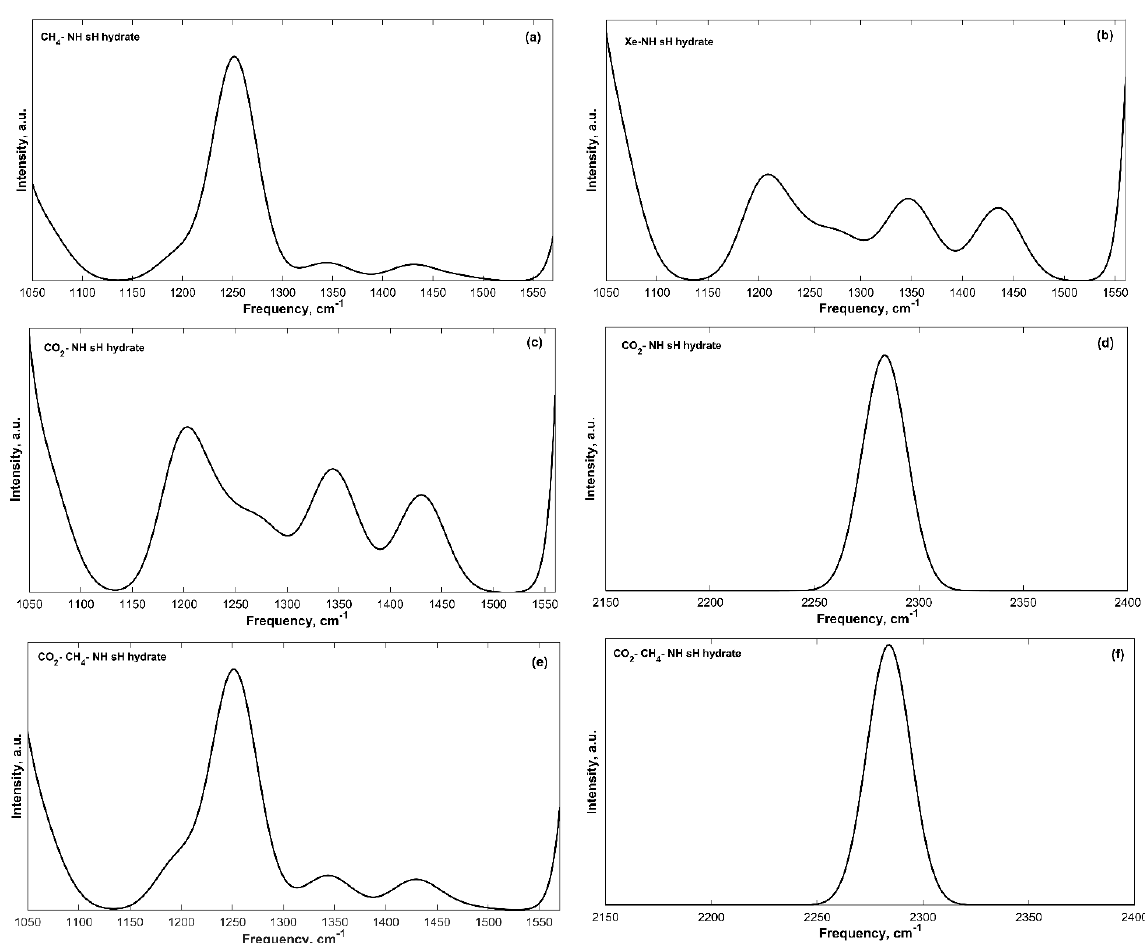
Figure 4. Guest vibration bands from convoluted IR spectra of filled sH gas hydrates. ( a ) CH 4 -NH sH hydrate; ( b ) Xe-NH sH hydrate; ( c ) CO 2 -NH sH hydrate; ( d ) CO 2 -NH sH hydrate (CO 2 asymmetric stretch band); ( e ) CO 2 -CH 4 -NH sH hydrate; ( f ) CO 2 -CH 4 -NH sH hydrate (CO 2 asymmetric stretch band).